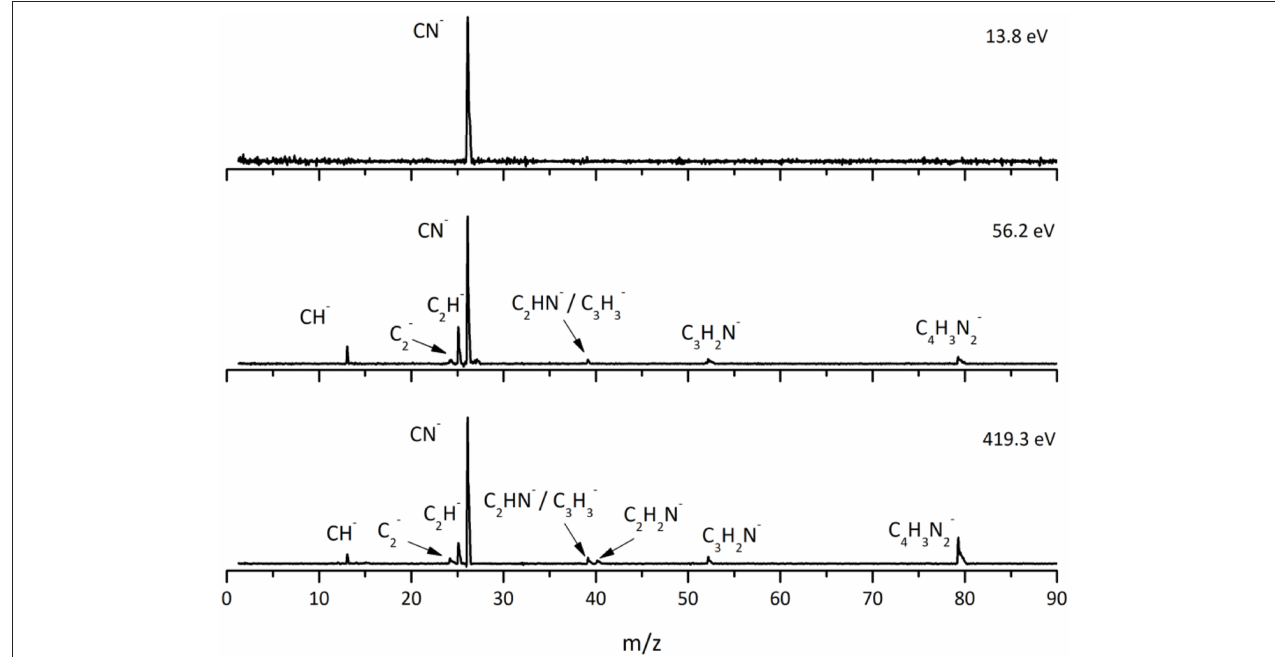
FIGURE 4 | Energy loss spectrum of K + ions measured in the forward direction in collisions of potassium atoms with pyrimidine (Pyr) at 111eV lab frame energy (67.2eV in the center-of-mass system). See text for details.